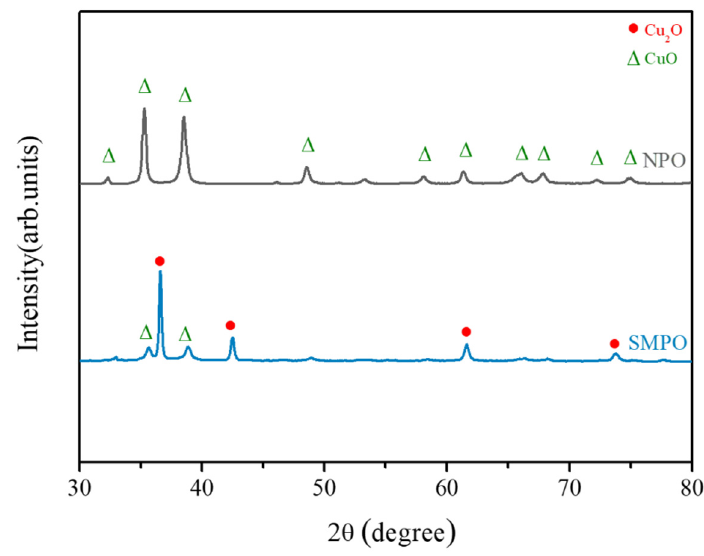
Figure 2. XRD results for submicron copper oxide particles (SMPO) and copper oxide nanoparticles (NPO).